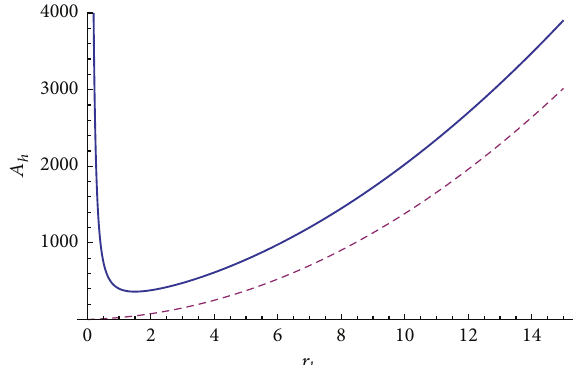
Figure 1: The figure shows horizon areas 𝐴 ℎ in 𝑝 -gauge (bold line) and in 𝐸 -gauge (dashed line) as a function of coordinate horizon radius 𝑟 ℎ , for parameters 𝑝 = 2 and 𝜅 = 1 . The mass 𝑀 of the BH is gauge-independent, and 𝑀/𝜅 is a monotonic function of 𝑟 ℎ /𝜅 (defined implicitly by 𝑁(𝑟 ℎ ) = 0 ). The exact profile of 𝐴 ℎ is gauge- dependent, but the divergence as 𝑟 ℎ → 0 is a generic feature in all regular